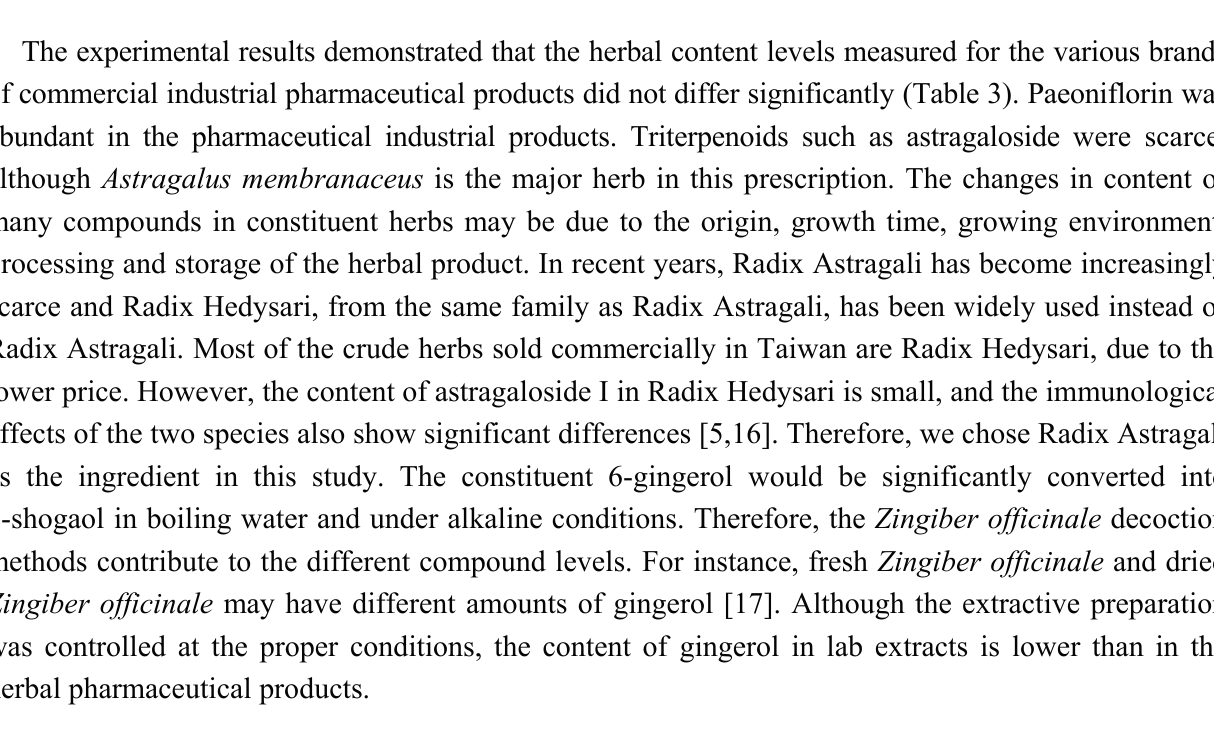
Table 3. The content of astragaloside I, astragaloside IV, formononetin, cinnamic acid, paeoniflorin, gingerol in lab-made herbal extract (EX) and five brands (A–E) of HGW herbal pharmaceutical